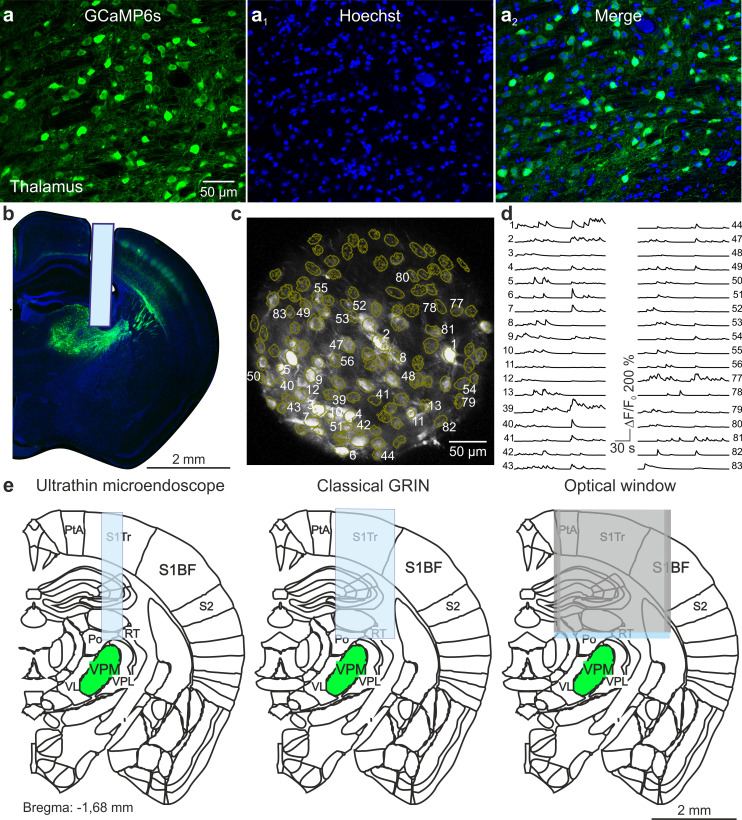
VPM imaging with type II eFOV-microendoscopes.(a-a2) Confocal images of thalamic neurons expressing GCaMP6s (a). Nuclei were counterstained with Hoechst (a1). Images are merged in (a2). Scale bar in (a) applies to a1-a2. (b) Confocal image showing a coronal slice from a mouse implanted with a type II eFOV-microendoscope. The slice was counterstained with Hoechst. (c) GCaMP6s-expressing VPM neurons recorded using type II eFOV-microendoscopes in an awake head-restrained mouse. ROIs are indicated in yellow. (d) Fluorescence signals over time for some of the ROIs displayed in c. (e) Schematic showing the implantation of an ultrathin microendoscope (left), of a larger cross-section GRIN lens (middle), and of an optical window (right) for VPM imaging. S1BF = primary somatosensory, barrel field; S1Tr = primary somatosensory, trunk region; PtA = parietal association region; S2 = second somatosensory cortex; VPM = ventral posteromedial thalamic nucleus; RT = reticular thalamic nucleus; Po = posteromedian thalamic nucleus; VPL = ventral posterolateral thalamic nucleus; VL = ventrolateral thalamic nucleus.